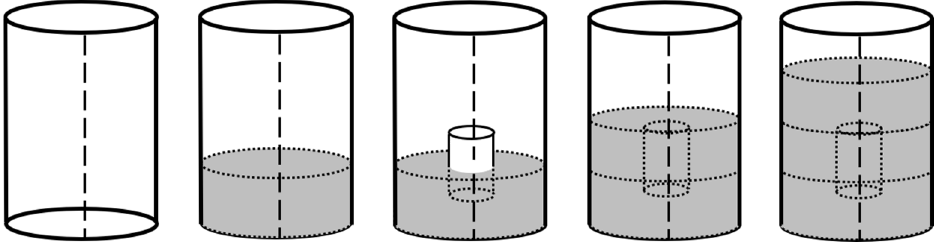
Figure 1. Schematic of the concrete cylinder casting procedure.